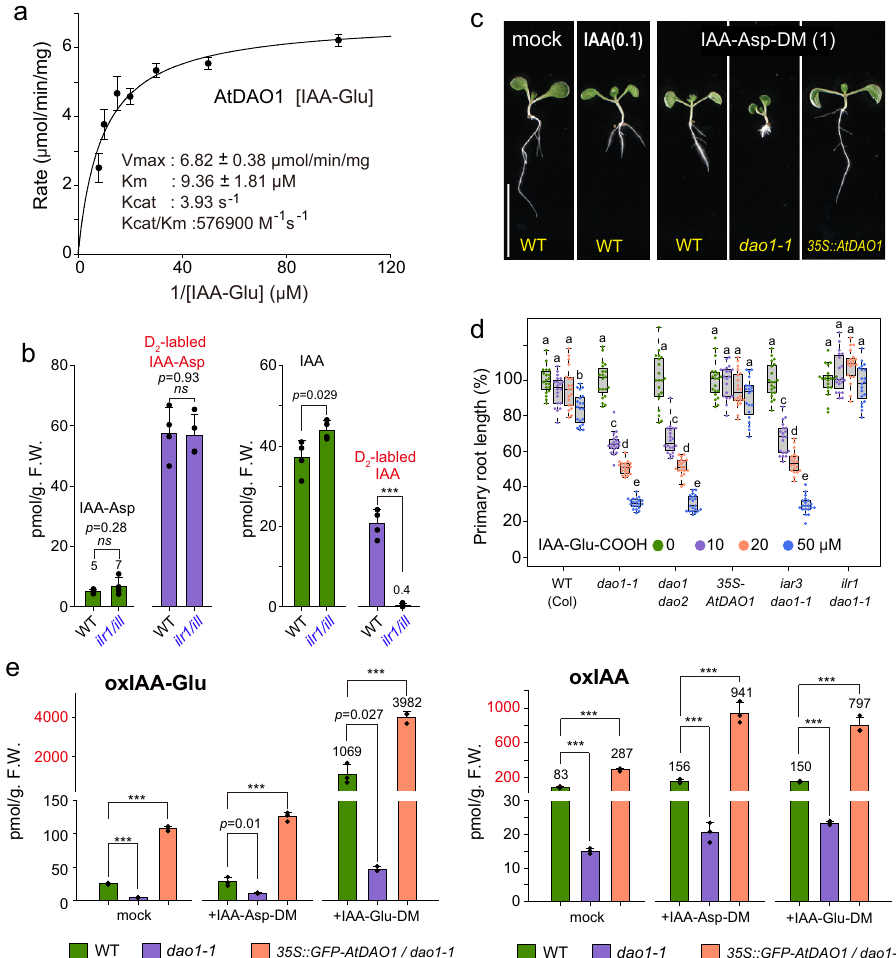
Fig. 3 DAO1 irreversibly oxidized IAA-amino acid conjugates in a plant. a Michaelis – Menten plot and kinetics parameters of the AtDAO1 enzyme for IAA-Glu ( n = 3). Error bars, SE. b in vivo conversion of IAA-Asp-DM to IAA. Endogenous and [D 2 ]IAA-Asp and [D 2 ]IAA were measured after incubation of 8-d-old WT and ilr1 ill2 iar3 ill3 ( ilr1/ill ) quadruple mutants with 1 μ M [D 2 ]IAA-Asp-DM for 6 h. The values shown are the means ± SD (*** P < 0.001, ns : not signi fi cant, two-tailed Student ’ s t test, n = 4). c Phenotypes of dao1-1- and AtDAO1 -overexpressing ( 35 S::AtDAO1 ) plants grown for 6 days with 1 μ M IAA-Asp-DM. Scale bar, 10 mm. d Effects of IAA-Glu on root growth in dao1-1 , dao1 dao2 , 35 S::AtDAO1 , iar3 dao1-1 , and ilr1 dao1-1 mutants. Root length (6-d- old) is shown as the percentage of that in mock-treated plants (100%). The different letters represent statistical signi fi cance at P < 0.001 (Tukey ’ s HSD test, n = 20). e The levels of IAA metabolites after treatment with IAA-amino acid diesters. WT, dao1-1 , and GFP-AtDAO1 -overexpressing dao1-1 mutants (7-d-old) were incubated for 20 h with the compounds. The values shown are the means± SD (*** P < 0.001, two-tailed Student ’ s t test, n =